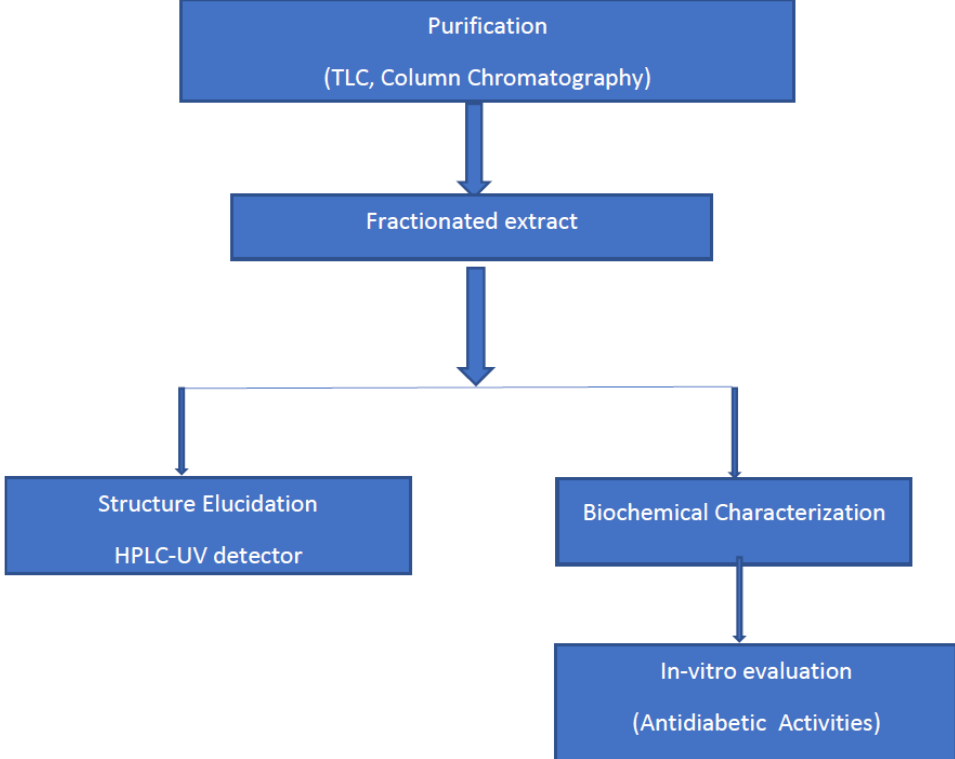
Fig. 1. A summary of the general approaches in extraction, fractionation and characterization of bioactive compounds from plant